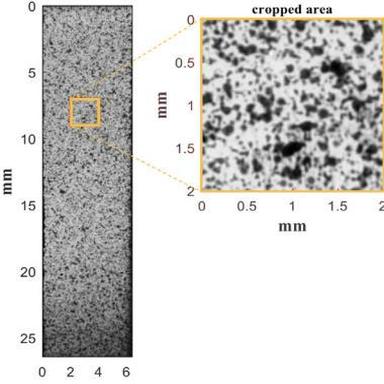
Specimen speckle surface.